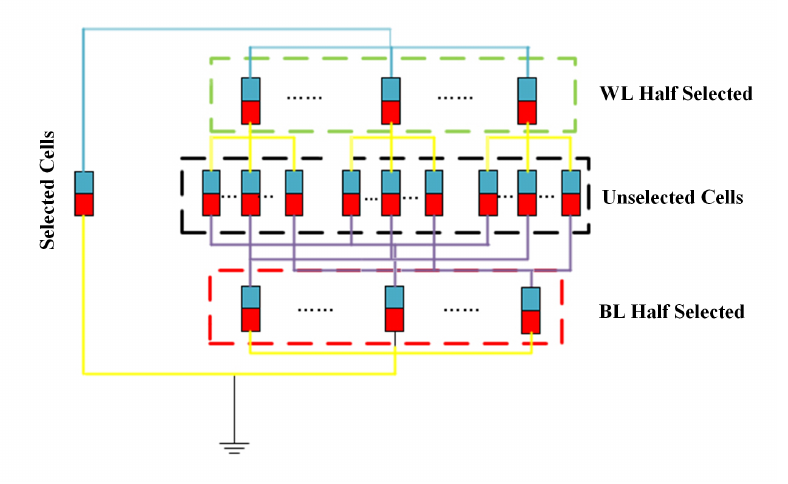
Figure 5. Leakage current model of the 3-D VRRAM